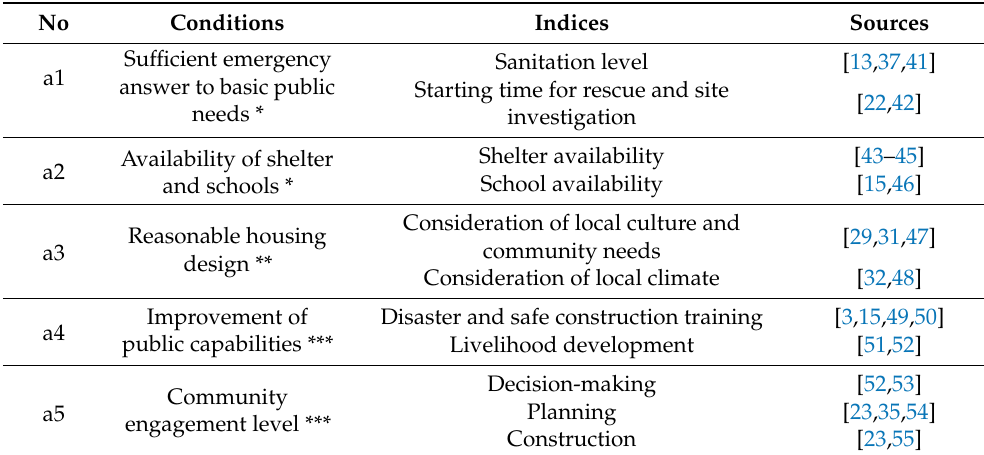
Table 2. Hypothesized causal conditions that influence the success dimensions of SNDR projects based on the community perspective.